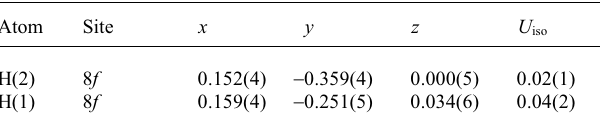
Table 2. Atomic coordinates and displacement parameters (in Å 2 )